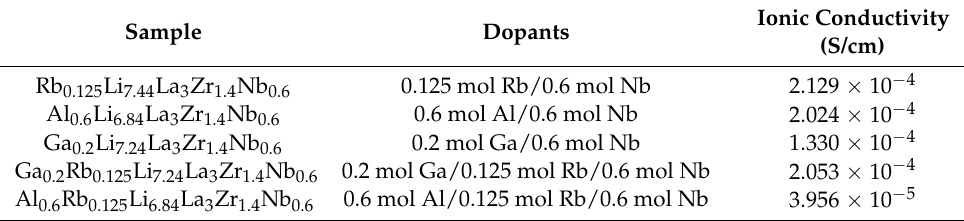
Table 1. Li-ion conductivity of co- and tri-doped LLZO solid-state electrolyte ceramics. Sample